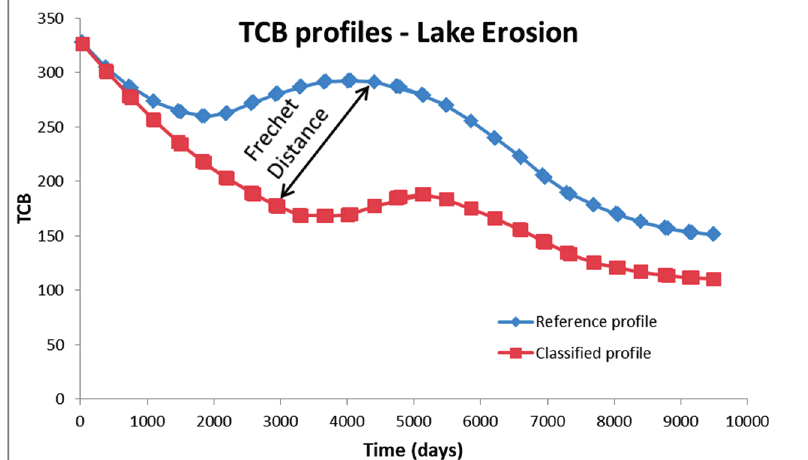
Figure 3. Reference and classified brightness profile examples of lake erosion with Frechet distance that is calculated as the minimum, maximum length that connects points on two curves. Frechet distance is commonly described as the minimum length of a leash required to connect a dog and its owner travelling along the two separate curves without either one